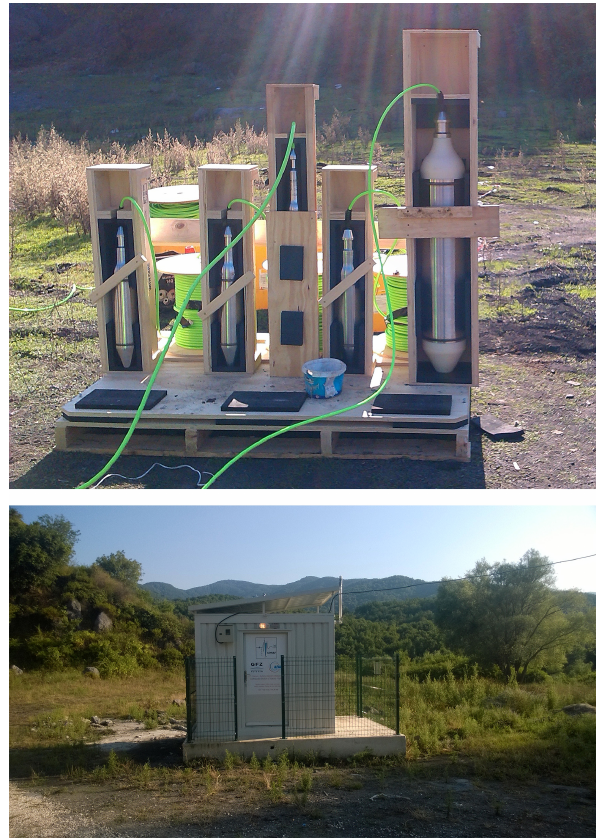
Figure 4. Upper part: GONAF downhole seismic instruments prior to deployment at the Kurtkoy station on the Armutlu Peninsula. The 300m deep, gimbaled 1Hz 3-C L4 seismometer sonde is on the right. In the middle is the combined 300m deep 3-C 15Hz DS200 and gimbaled 2Hz HS-1 sonde. The other three sondes are the ver- tically distributed, gimbaled 1-C 1Hz L4 seismometers. For redun- dancy each sonde has its own waterproof signal cable with an inter- nal Kevlar stress member. Lower part: the 10ft containers used to cover each station and to house the special low-noise Guralp CMG- DM recorders, telemetry systems, and their support